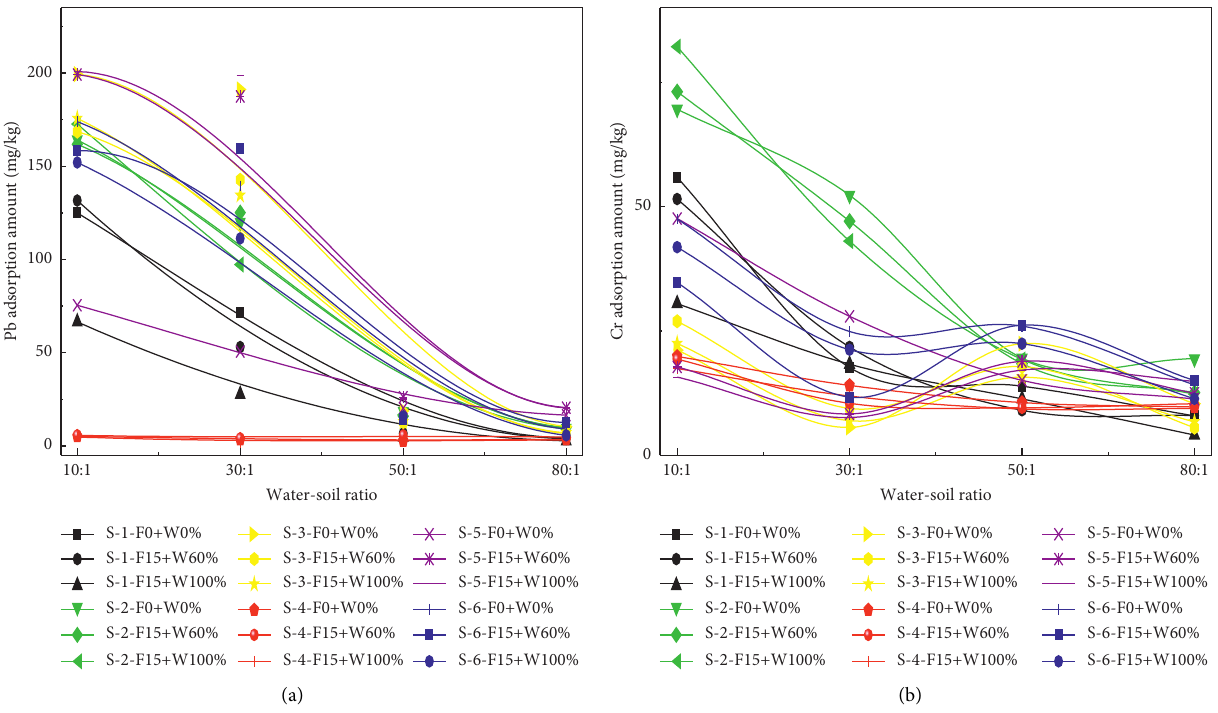
Figure 1: Relationship between water-soil ratio and Pb or Cr adsorption amount in soils under different freeze-thaw conditions. F0 and F15 refer to the number of freeze-thaw cycles (0 and 15 cycles), and W0%, W60%, and W100% refer to water ratio of field capacity (0%, 60%, and 100% water